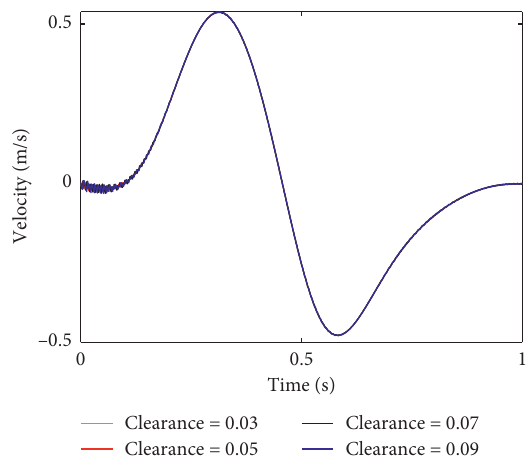
Figure 15: Velocity of the slider with different clearance values.